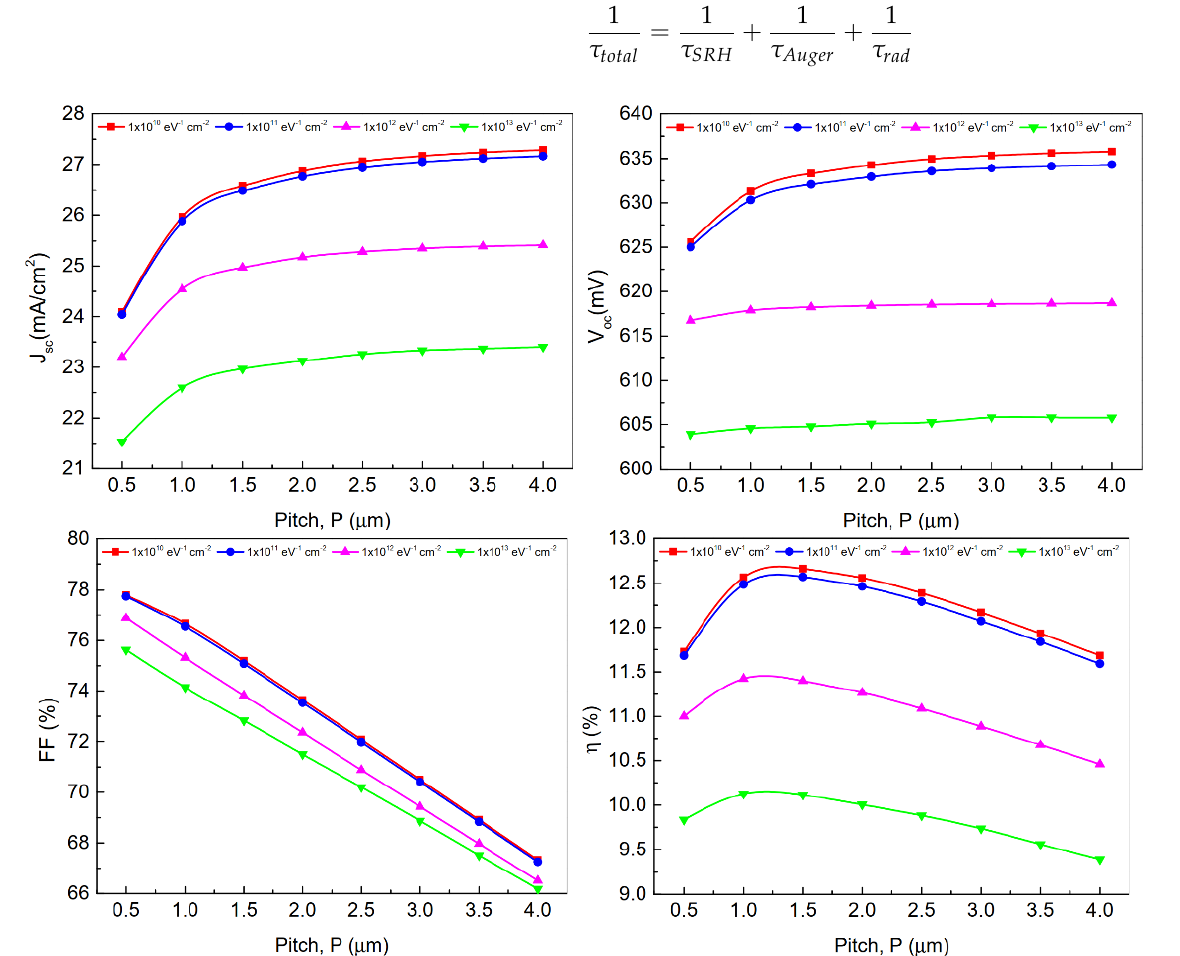
Figure 5. Cell parameters as a dependence of cell pitch extracted from 2D simulations for different chemical passivation D it . The optimum pitch shifts from about 1 µm to 2 µm with a reduction in D it . Lines are a visual guide.